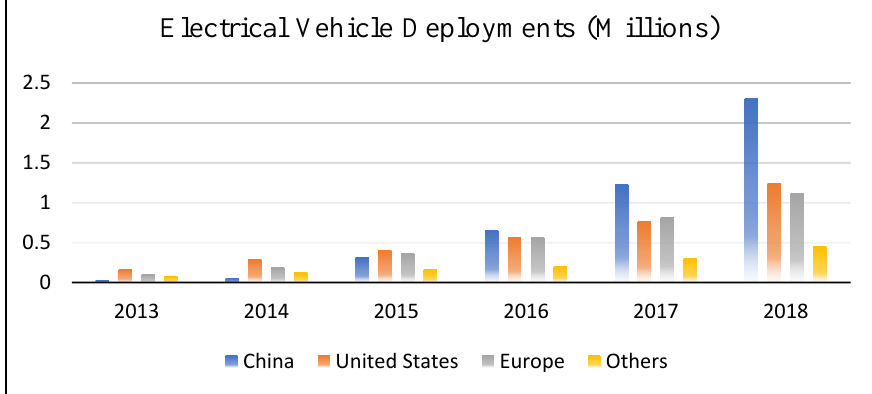
Figure 1. Global EV deployments 2013–2018 [Data from: International Energy Agency 2019].